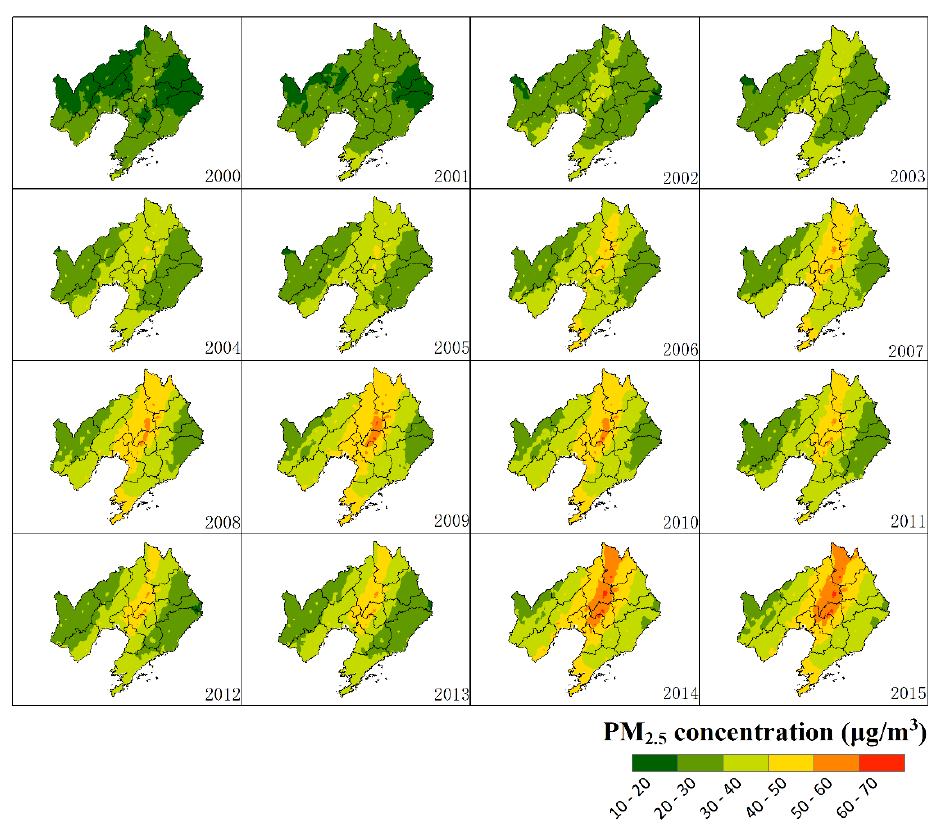
Figure 2. Spatial distribution of surface PM 2.5 concentrations in Liaoning province from 2000 to 2015.